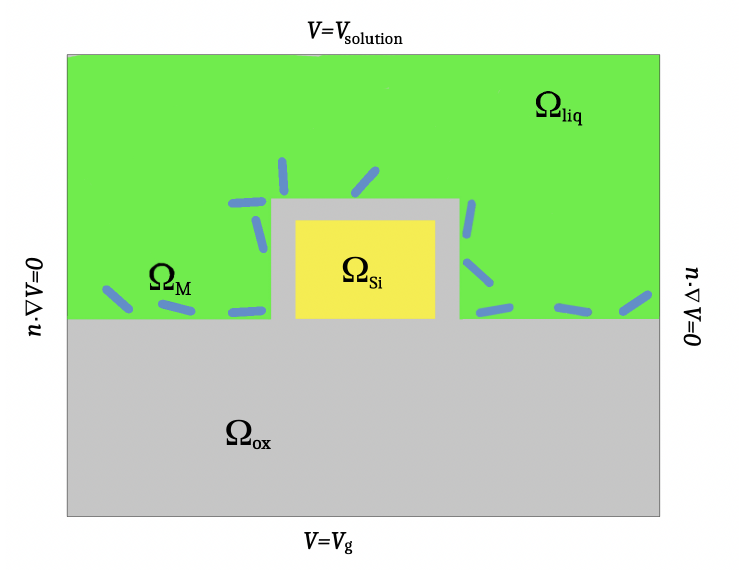
Figure 1. A schematic cross-section of a SiNW-FET depicting the subdomains, i.e., the transducer Ω Si , SiO 2 insulator ( Ω ox ), the aqueous solution Ω liq , the binding of the target molecules to the immobilized receptor molecules ( Ω mol ), and the boundary